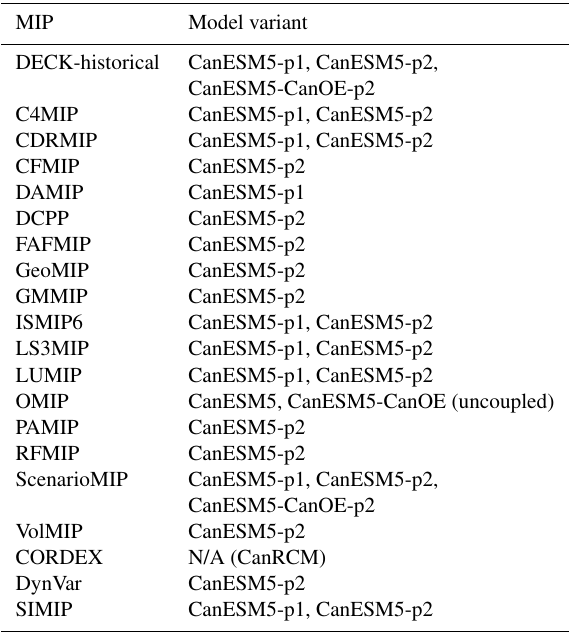
Table D1. List of MIPs and model variants of CanESM5 planned for submission to